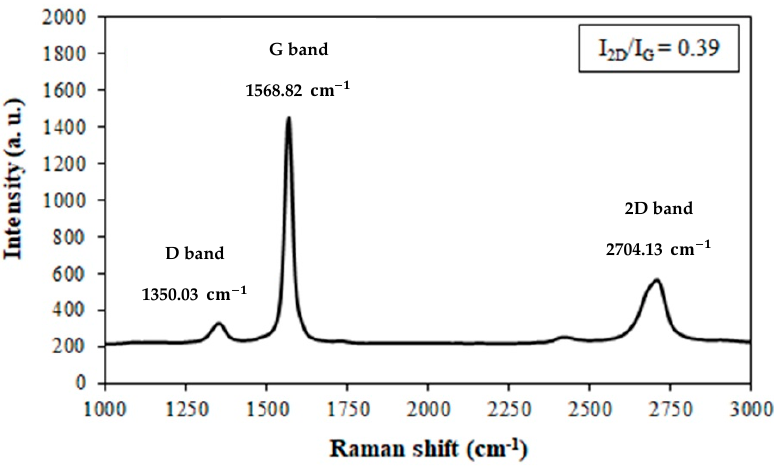
Figure 1. Raman spectrum of the GNP SA deposited on fiber ferrule.